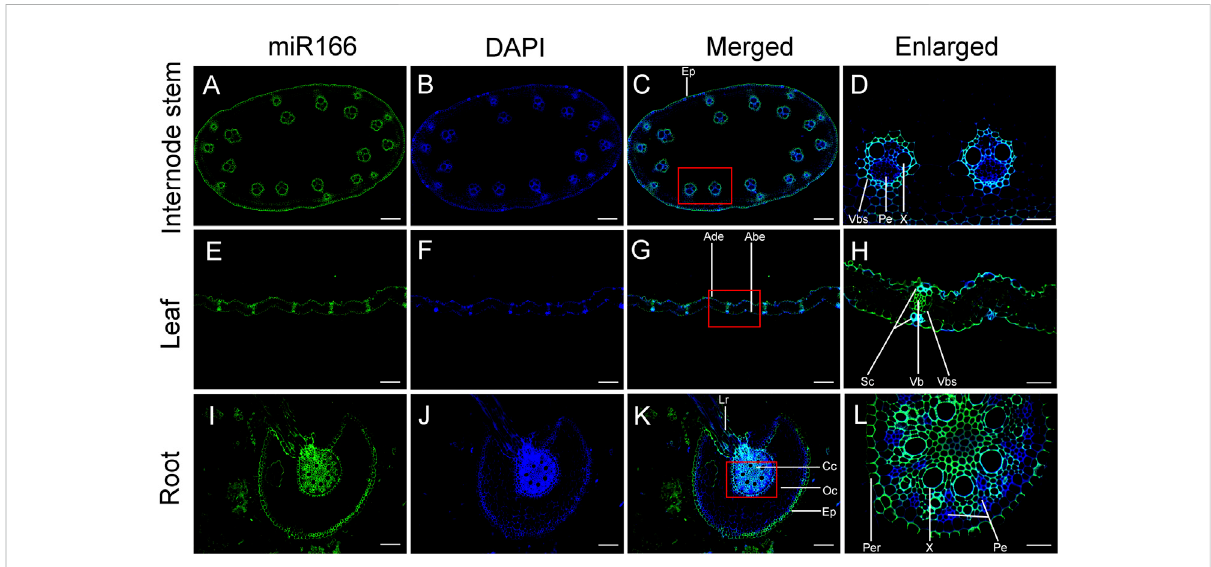
FIGURE 7 Veri fi cation of the localization of miR166s to vascular tissues of the internode, leaf, and root of two-month-old Moso bamboo seedlings by fl uorescence insitu hybridization (FISH). ped-miR166a-3p was localized to thevasculartissues oftheinternode (A – D) , leaf (E – H) ,and root (I – L) . Ep, epidermis; Vb,vascular bundle; Vbs, vascular bundle sheath; Pe,phloem;X,xylem;Ade,adaxialepidermis; Abe,abaxialepidermis; Sc,sclerenchyma; Lr, lateral root; Cc, central cylinder; Co, cortex; Per, pericycle. Bar = 100